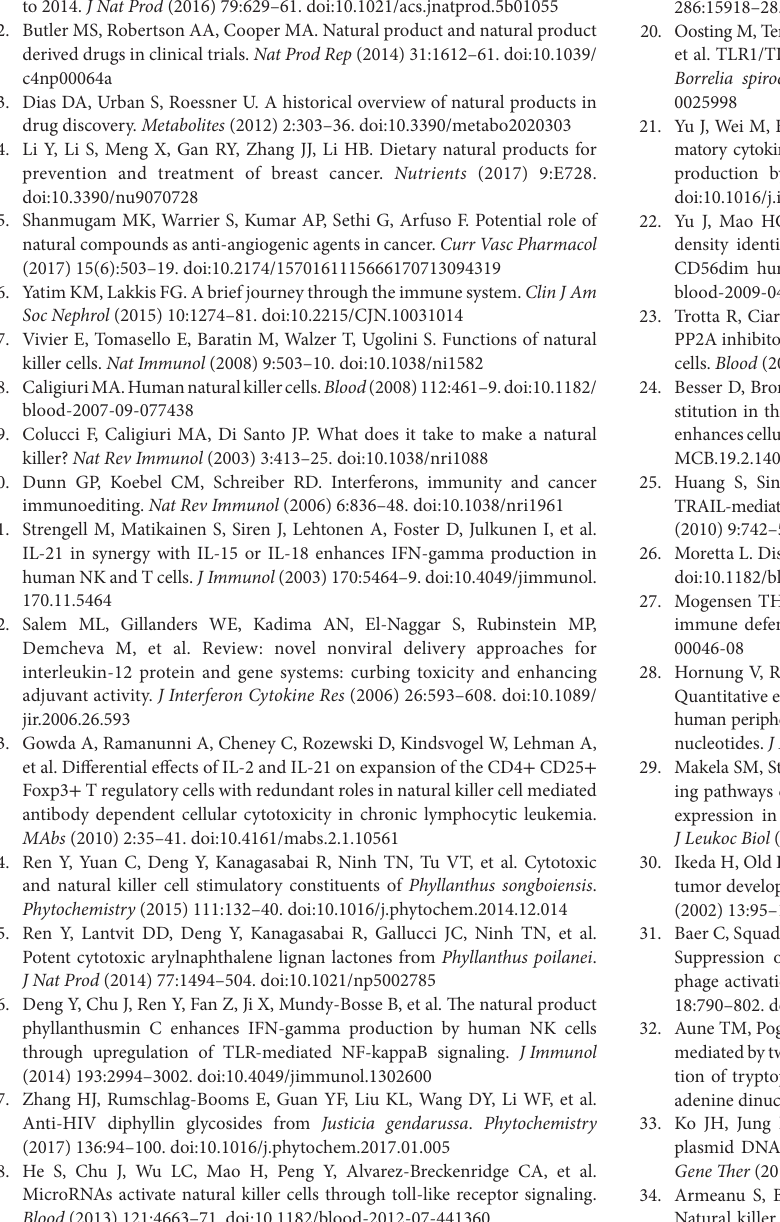
FigUre s7 | TAARD enhances NF- κ Bp65 and STAT3 promoter reporter activities through TLR signaling. (a) 293T cells were co-transfected with either pGL3- κ B- luc (1 µg) or pGL Basic plasmid and pRL-TK renilla-luciferase control plasmids (5 ng) in the presence or absence of a TLR3 expression plasmid (0.5 µg). (B) 293T cells were co-transfected as described in (a) but with a TLR6 (0.5 µg) instead of a TLR3 expression plasmid. (c) 293T cells were co-transfected with either 4 × M67 pTATA TK-Luc or pGL Basic and pRL-TK renilla-luciferase control plasmids (5 ng) in the presence or absence of a TLR1 expression plasmid (0.5 µg). (D) NKL cells were co-transfected as described in (c) but with a TLR6 expression plasmid (0.5 µg) instead of TLR-1 expression plasmid. Cells were treated and the luciferase activities were measured as described in Figure 5